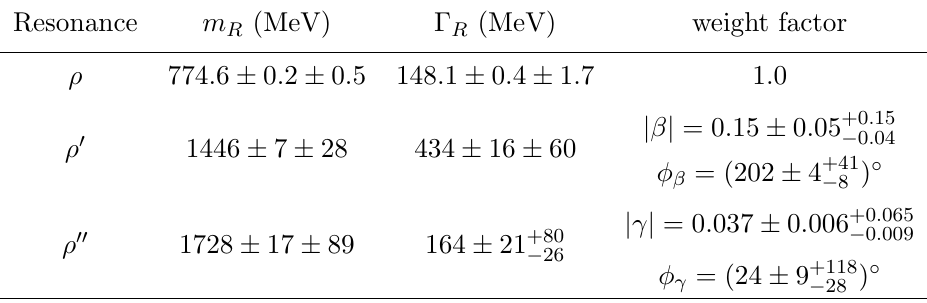
Table 4 . Numerical parameters for the pion timelike form factor model from ref.